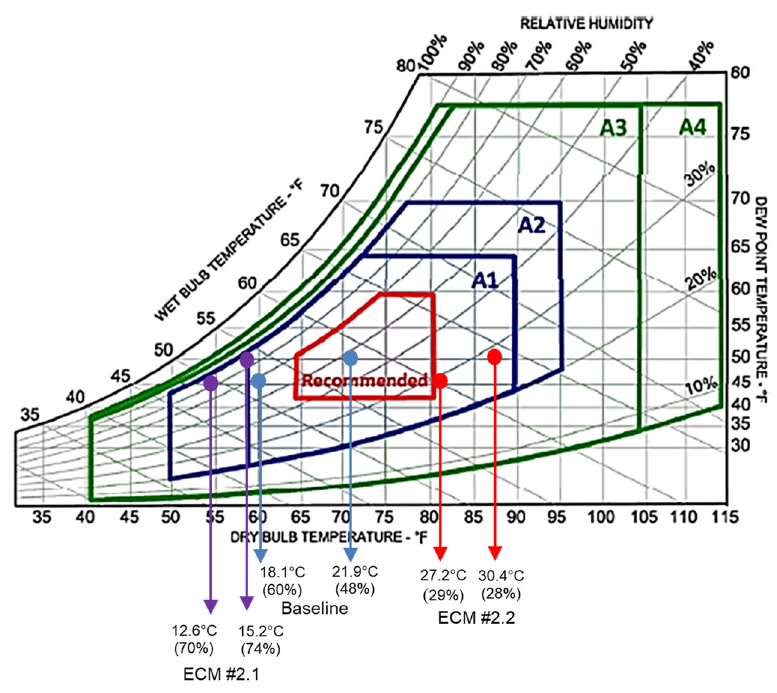
Figure 5. Sever inlet conditions in the ASHRAE guideline for ECMs #2.1 and #2.2 [22].